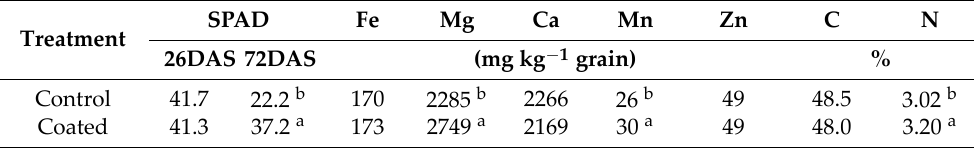
Different letters indicate significant differences at level of p < 0.05 between control and coated